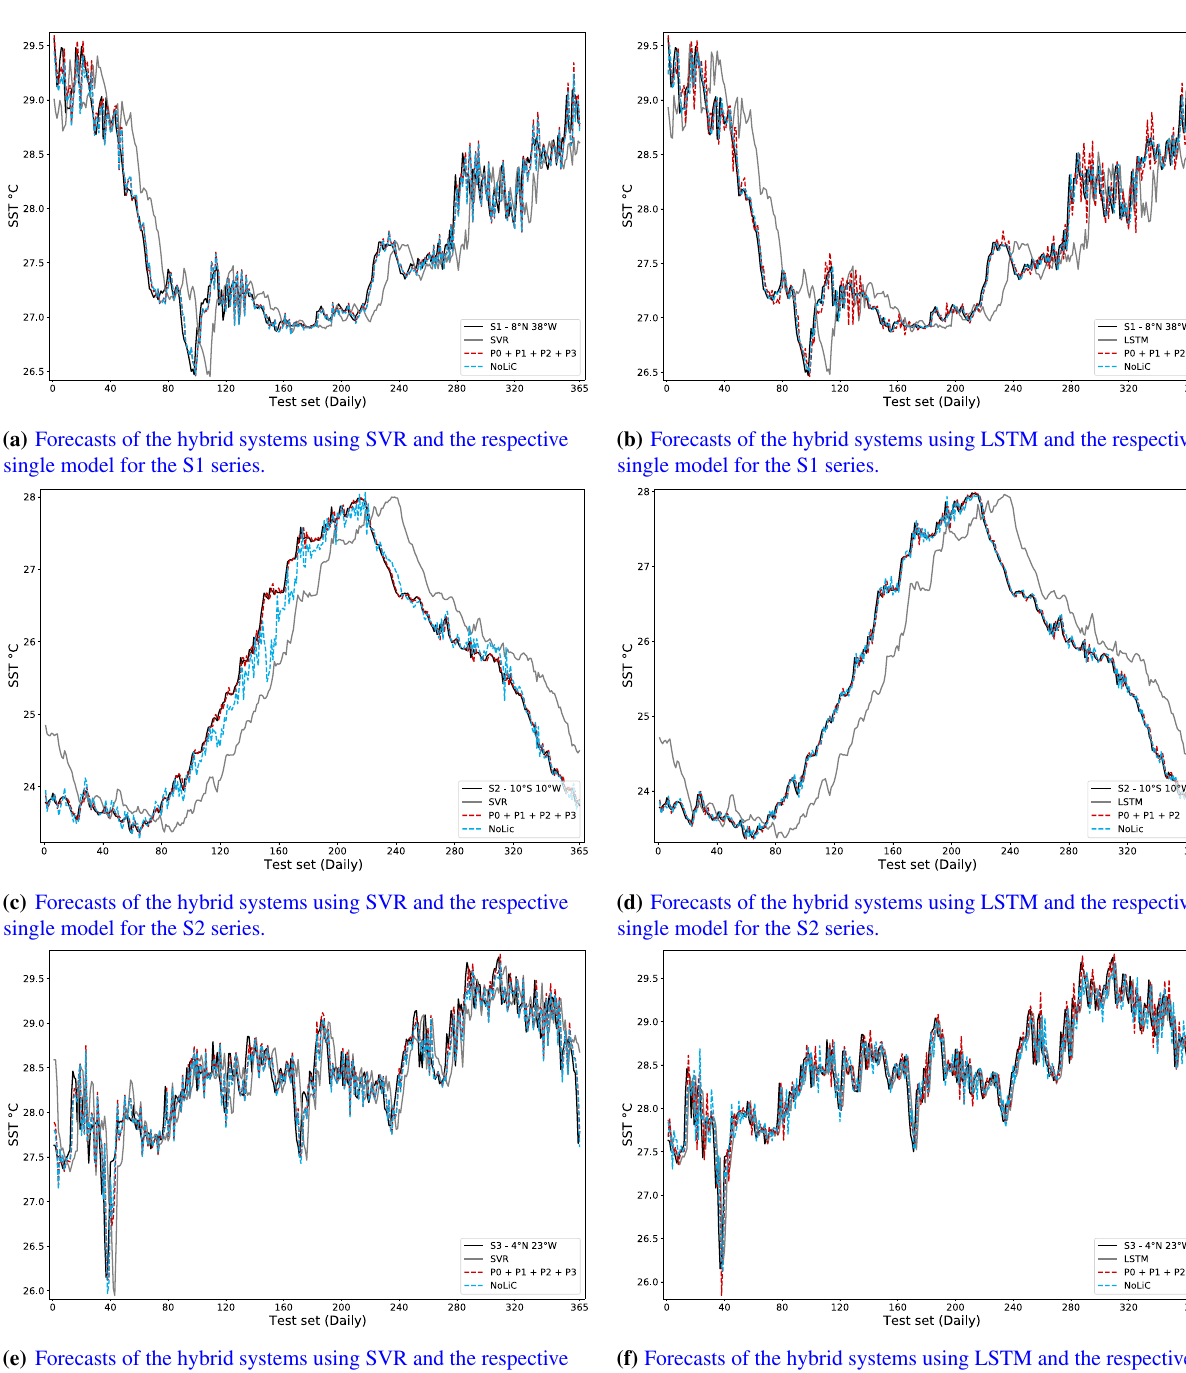
Figure 4. One day ahead forecasting for the SST time series on the test set with Perturbative approach, NoLiC and the respective single